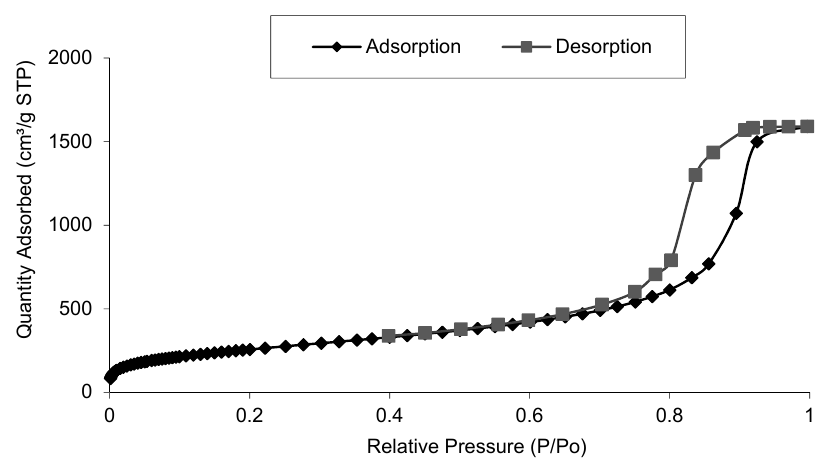
Figure 7. Isotherm adsorption—desorption curve for silica aerogels.